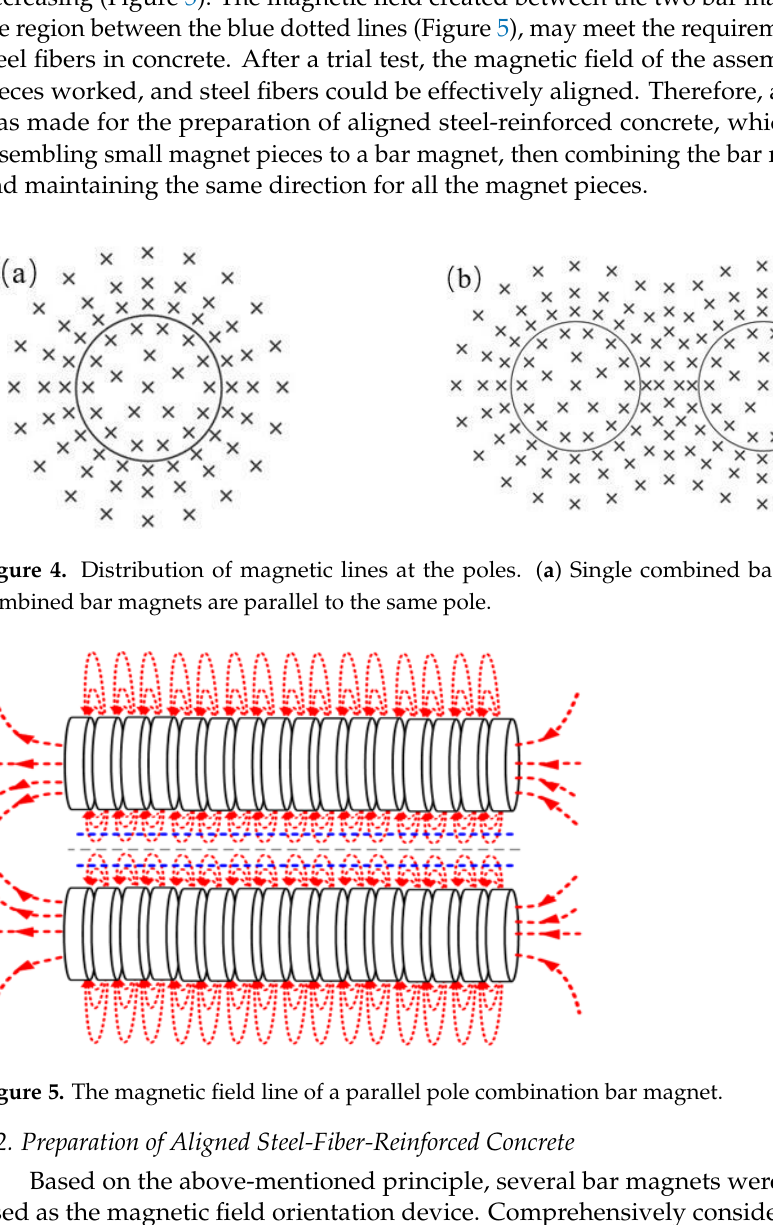
Figure 3. The distribution of the magnetic lines of combined bar magnets. ( a ) Three bar magnets; ( b ) multiple bar magnets .